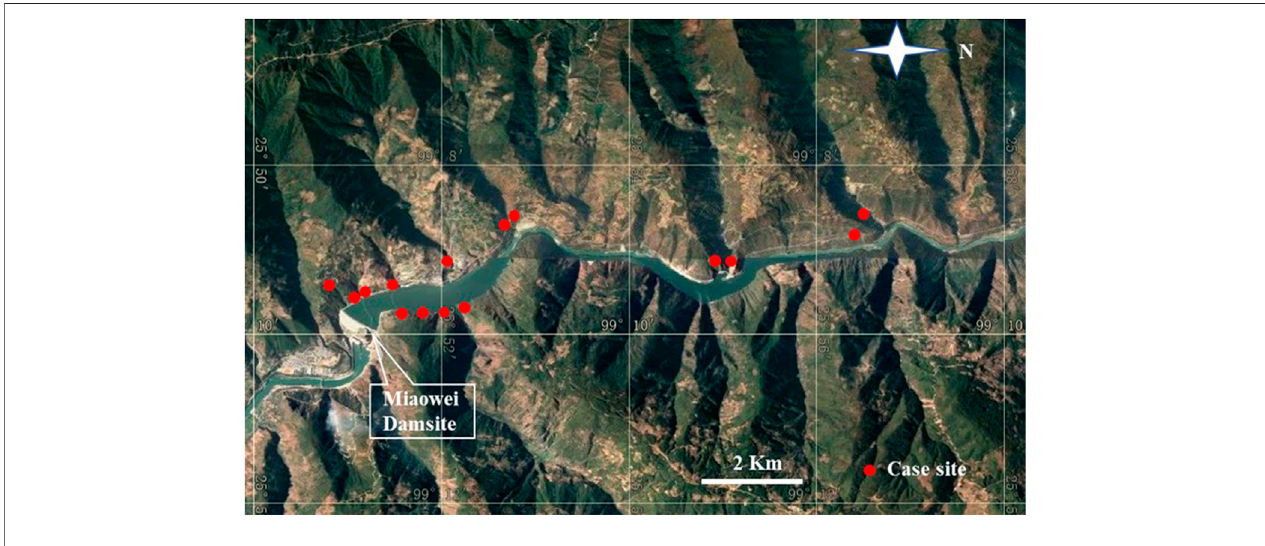
FIGURE 5 | Cases from bank slope on the Miaowei Hydropower Station.